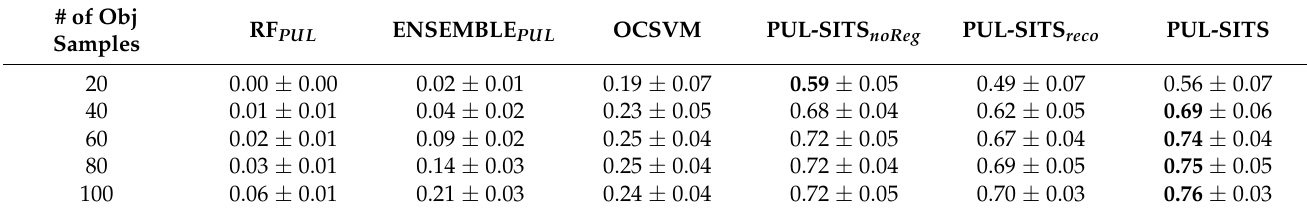
Table 8. Performances in term of the Kappa measure of the different competing strategies when the land cover class of interest (the positive class) is Cereals/Oilseeds .